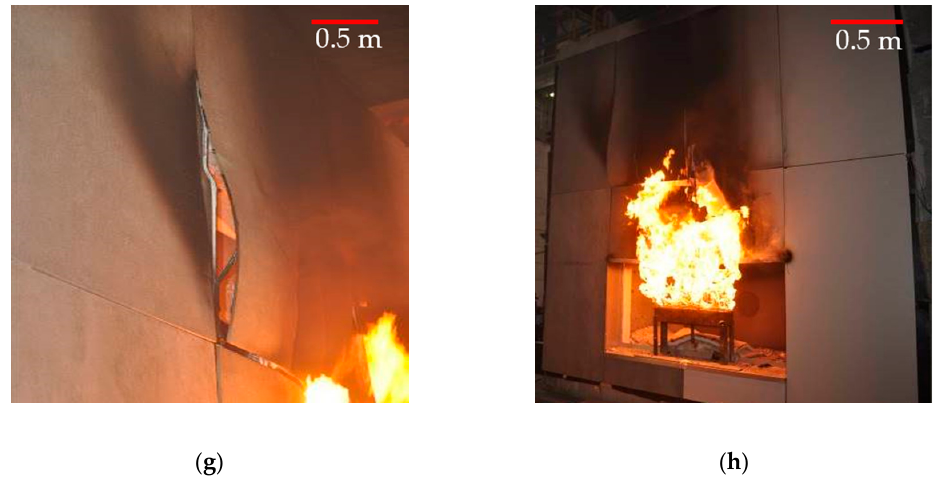
Figure 4. Ventilated facade model view in subsequent test minutes.: ( a ) 1st minute of the test; ( b ) 6th minute of the test; ( c ) 11th minute of the test; ( d ) 21st minute of the test; ( e ) 31st minute of the test; ( f ) 41st minute of the test; ( g ) 56th minute of the test; ( h ) 61st minute of the test.